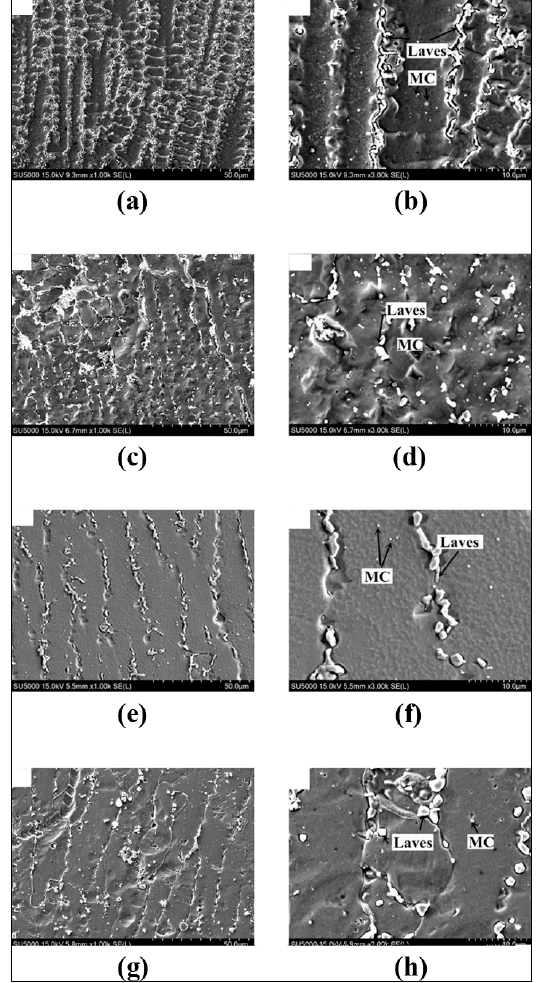
Figure 10. As-deposited and annealed samples at different temperatures; the vertical cross-section (Plane B, X-Z): ( a , b ) without heat treatment; ( c , d ) 1000 °C; ( e , f ) 1100 °C; ( g , h ) 1200 °C (adapted with permission from [38] 2017, Emerald Publishing).